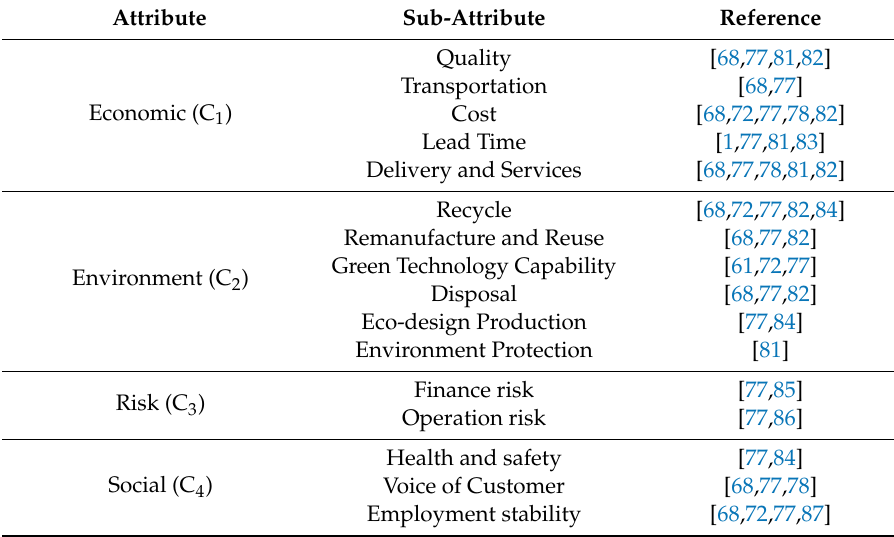
Table 3. Core attributes for sustainable 3PRLP selection.